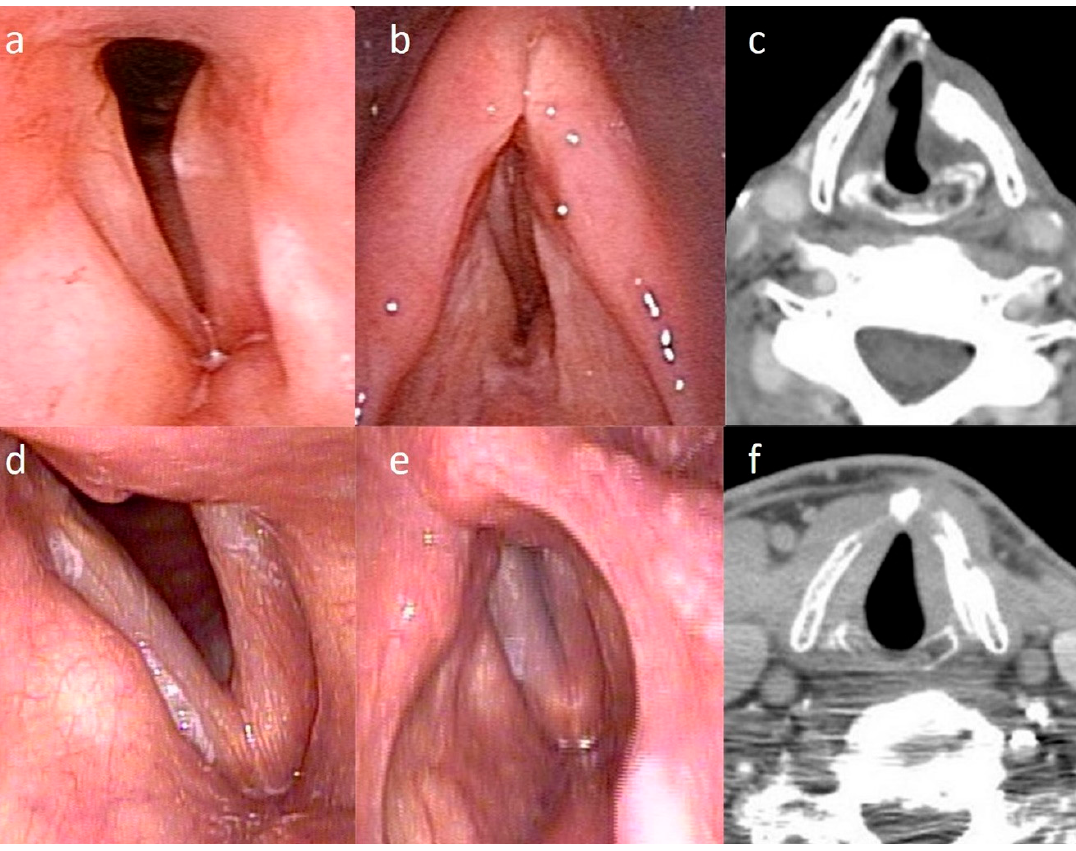
Figure 2. The images of laryngoscopy and axial view of computed tomography were obtained